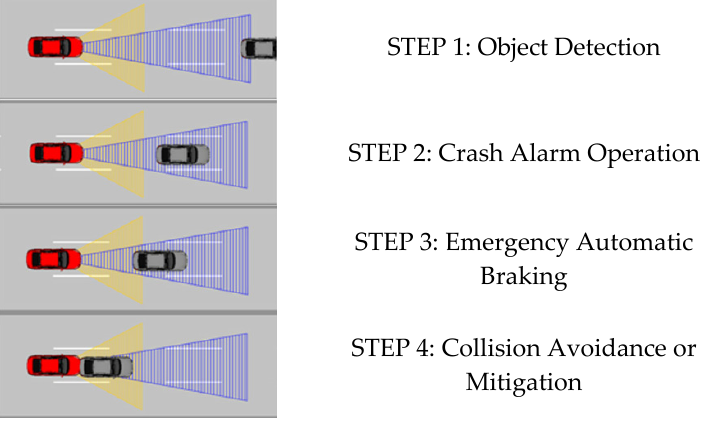
Figure 1. AEBS operations.